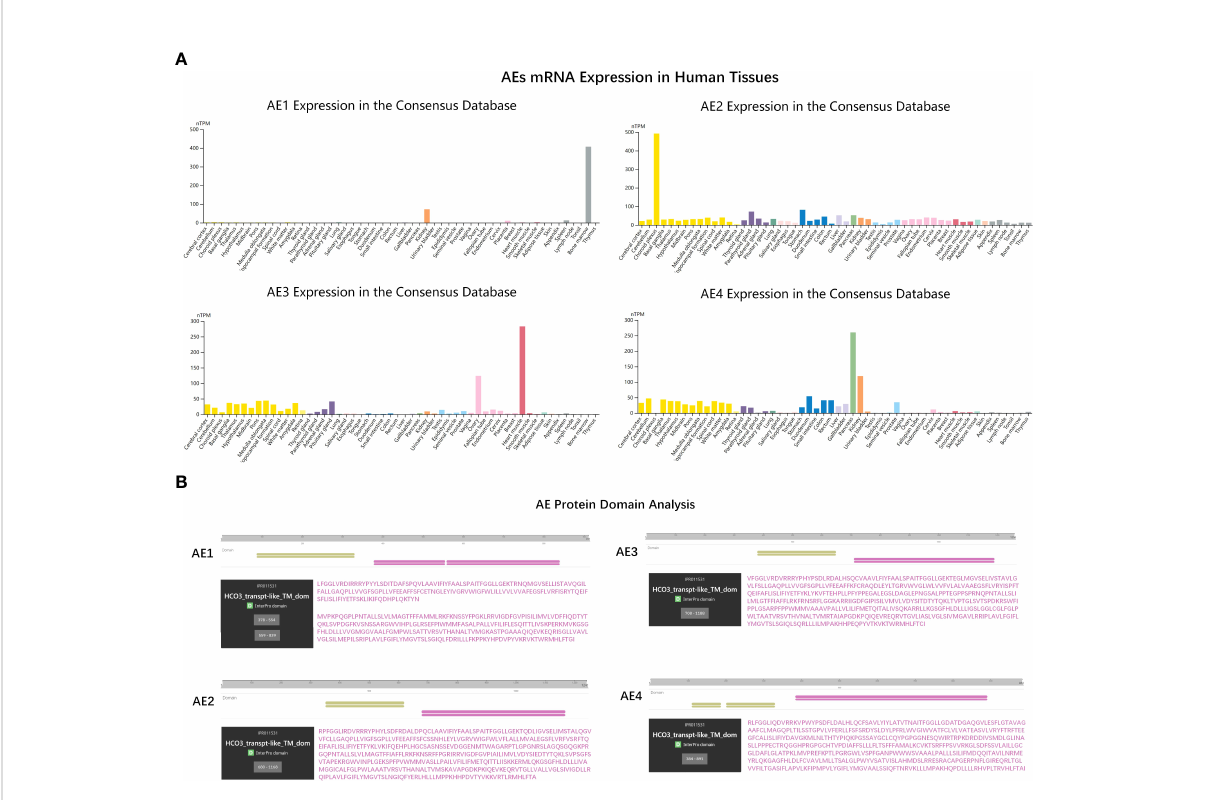
FIGURE 5 The gene expression and molecular function analysis of AEs. (A) The bar-plots showed tissue speci fi city of AEs mRNA expression in human based on RNA-sequencing data from the consensus dataset. (B) The protein domain analysis of the AE family (AE1-4). The amino acid sequences of key domains are shown in purple. HCO3 - transpt-like_TM_dom, Bicarbonate transporter-like transmembrane domain.